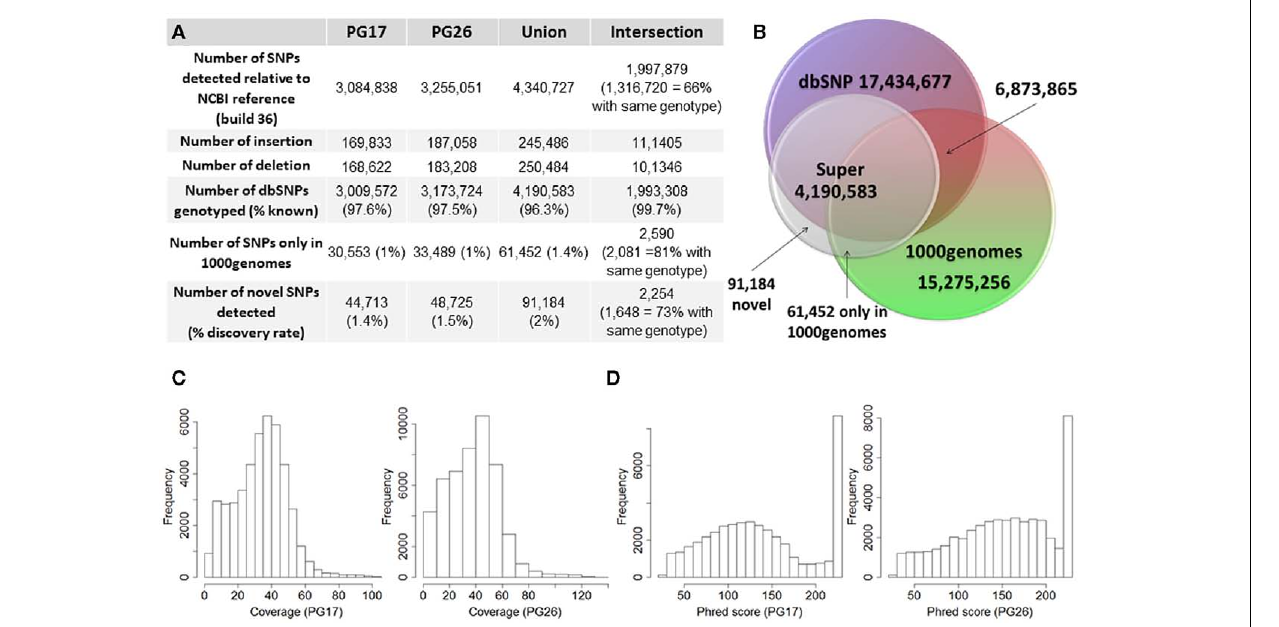
FIGURE 2 | (A) Summary of SNPs and small insertions and deletions (Indels) detected in the two sequences, their union and intersection.The January 2011 release of the 1000 Genomes was used to compare the SNPs detected in the two sequences that were not found in dbSNP. (B) Venn diagram that